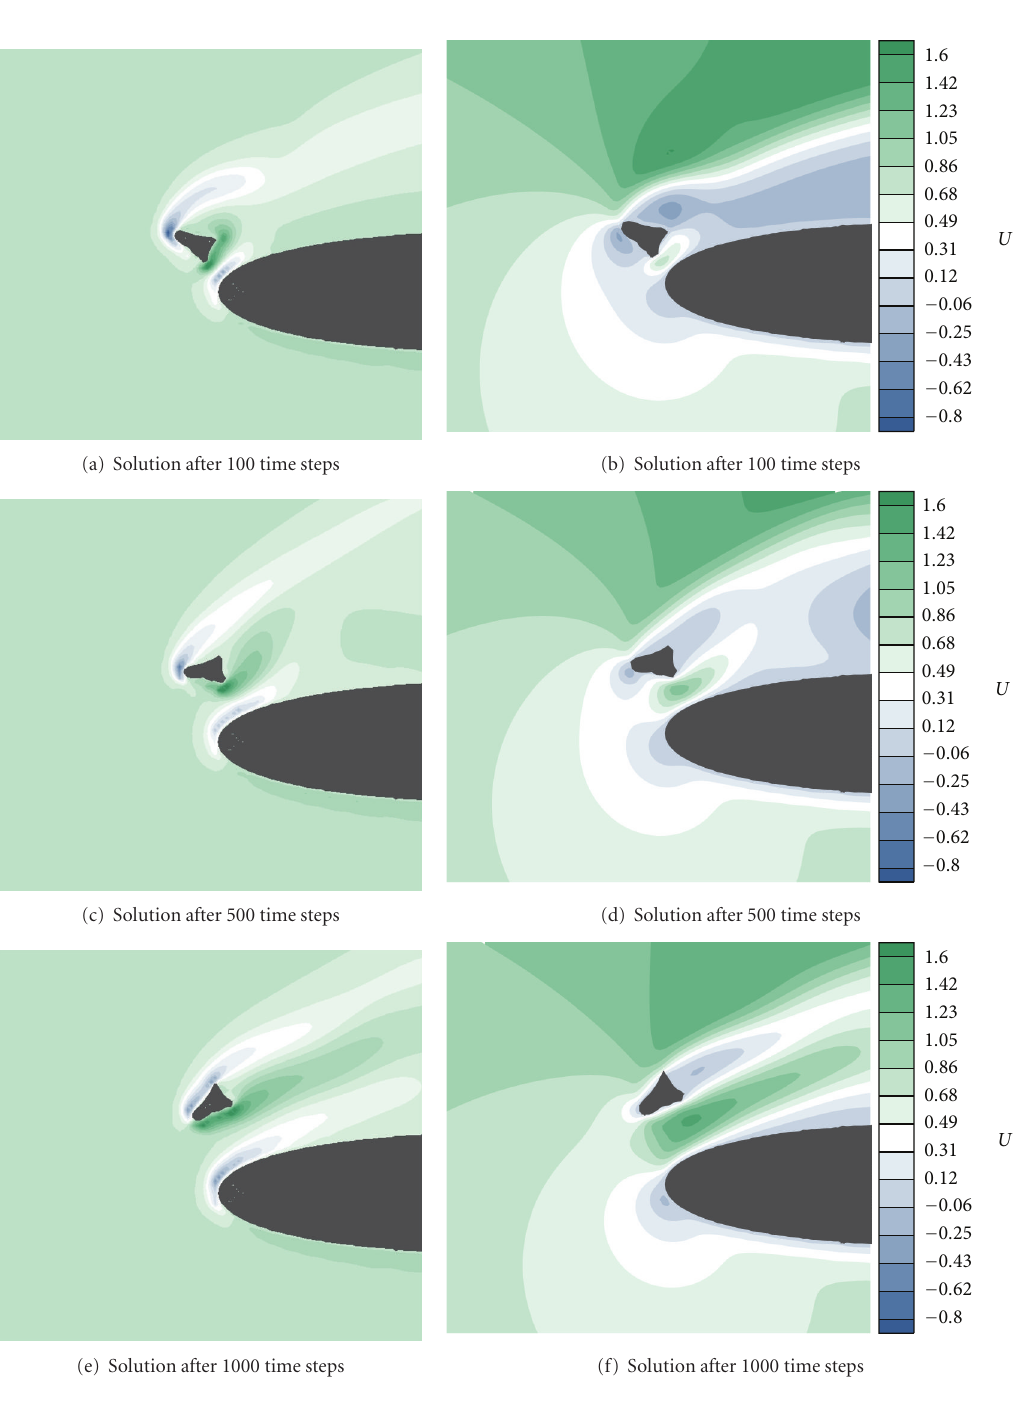
Figure 15: Ice shedding around NACA 0012 at Re = 1000. On the left: vorticity contours (green positive, blue negative). On the right: U velocity